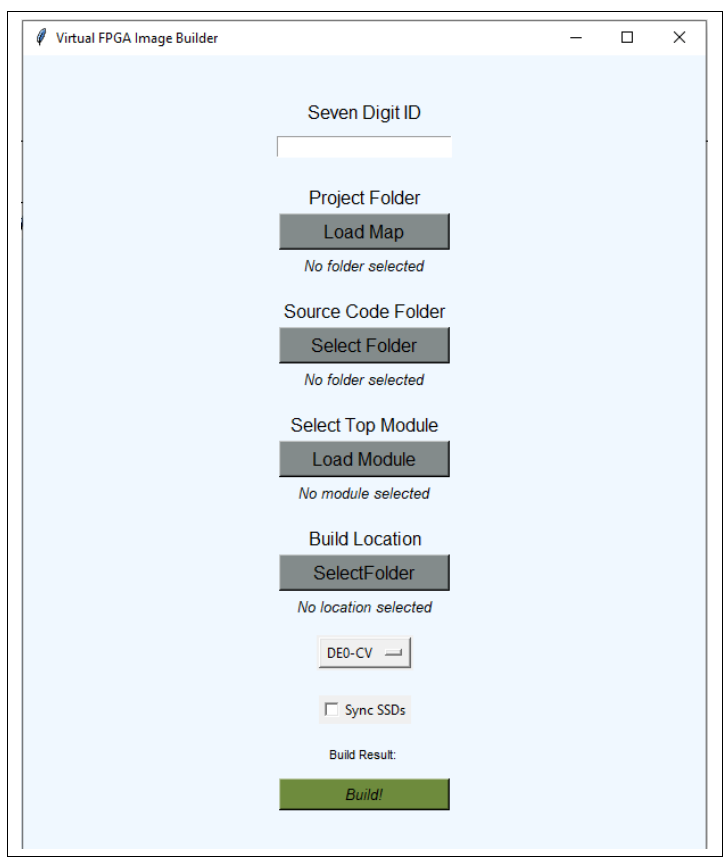
Figure 8. The Python Wizard GUI.